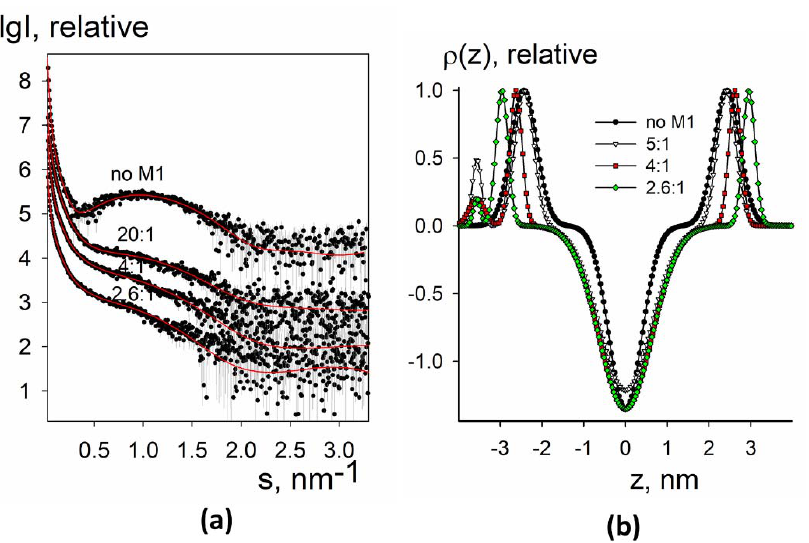
Figure 7. SAXS and BILMIX analysis of proteoliposomes composed of lipids from A/Puerto Rico/8/34 (H1N1) virus envelope together with the HA LI45 peptides loaded with M1 protein. ( a ) Experimental curves are shown by dots with error bars; the fits obtained by BILMIX are shown as red curves. The curves are shifted by one logarithmic order for better clarity; ( b ) the restored electron density profiles of the lipid bilayer before (black curve) and after (color curves) loading with M1. The molar lipid:M1 ratios are the following: no M1, 5:1, 4:1,